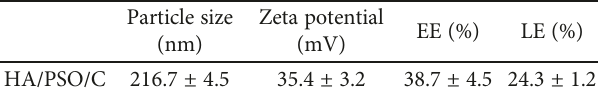
Table 1: Characterization of HA/PSO/C NPs (mean ± SD, n = 3 ).